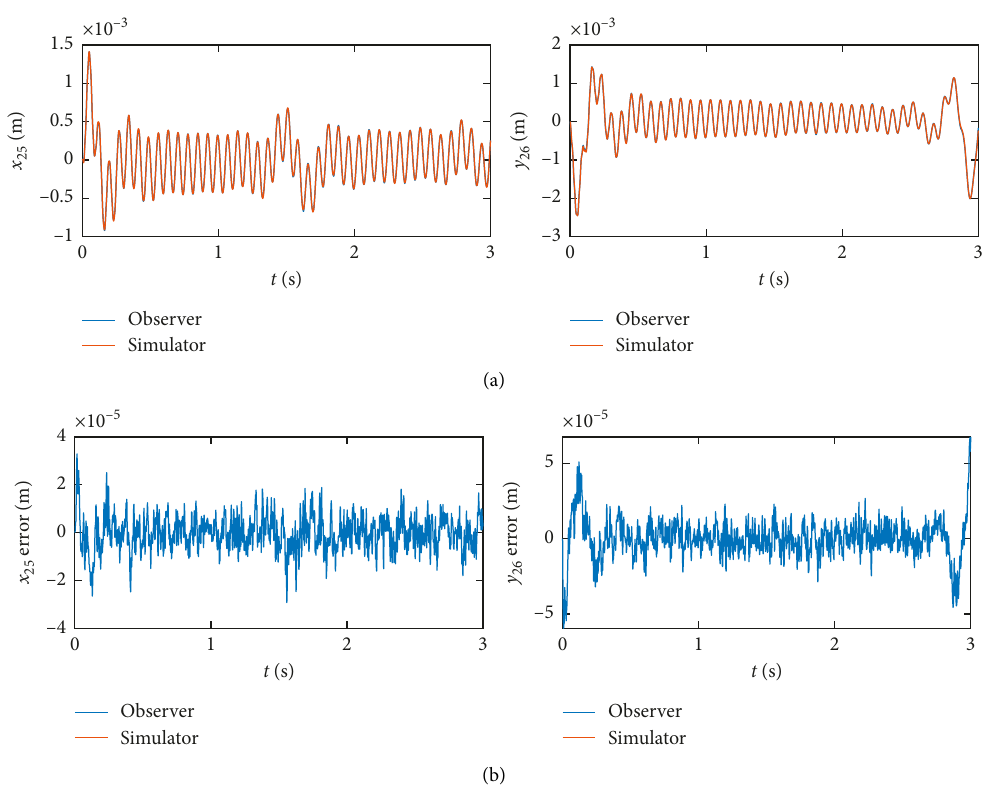
Figure 8: Estimated elastic displacements of the elastic coordinates of the end-effector (a) and estimation error